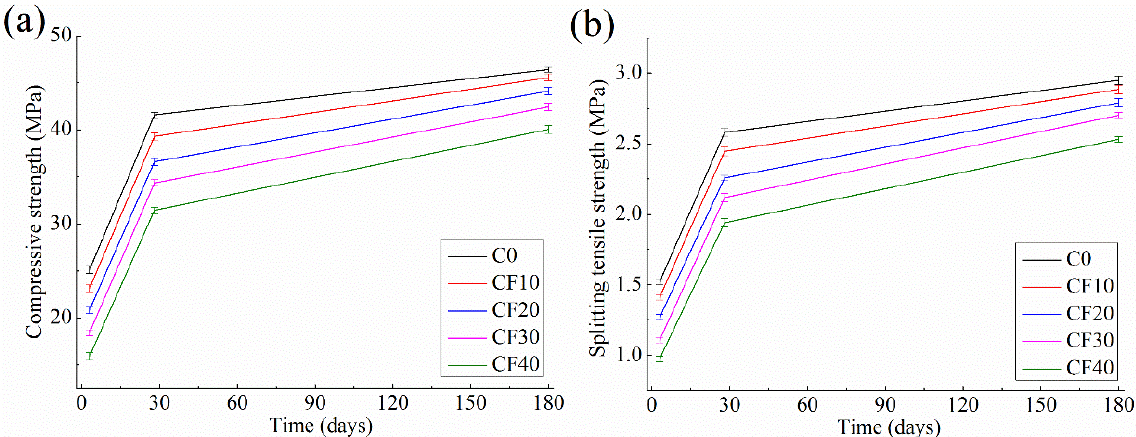
Figure 3. Strengths of face slab concretes at 3, 28 and 180 days: ( a ) compressive strength and ( b ) splitting tensile strength. ( b ) splitting tensile